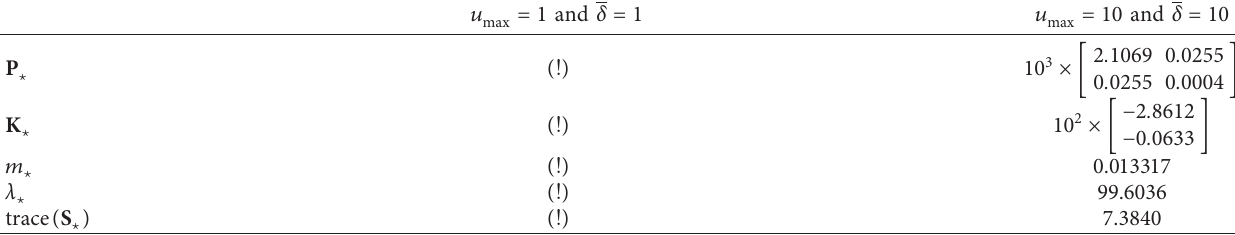
� 1 and u � 10. max max